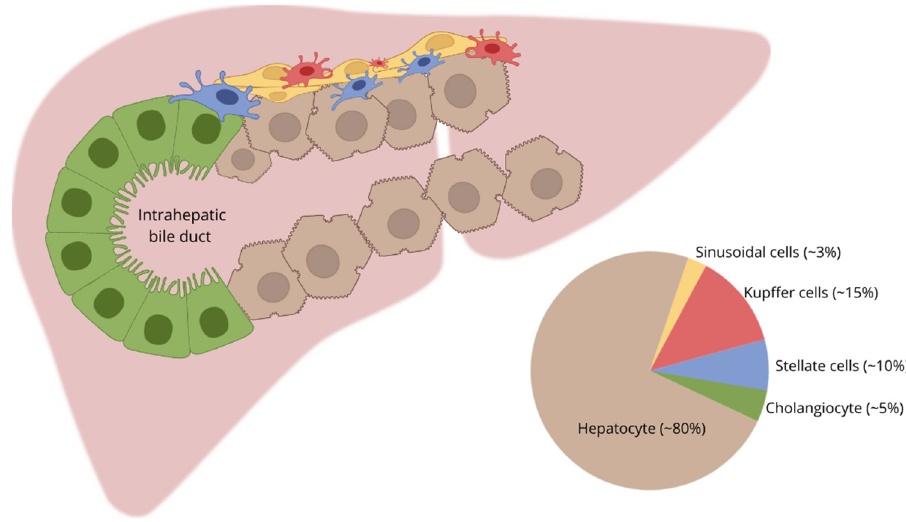
Figure 1. Types of human liver cells and their distribution.